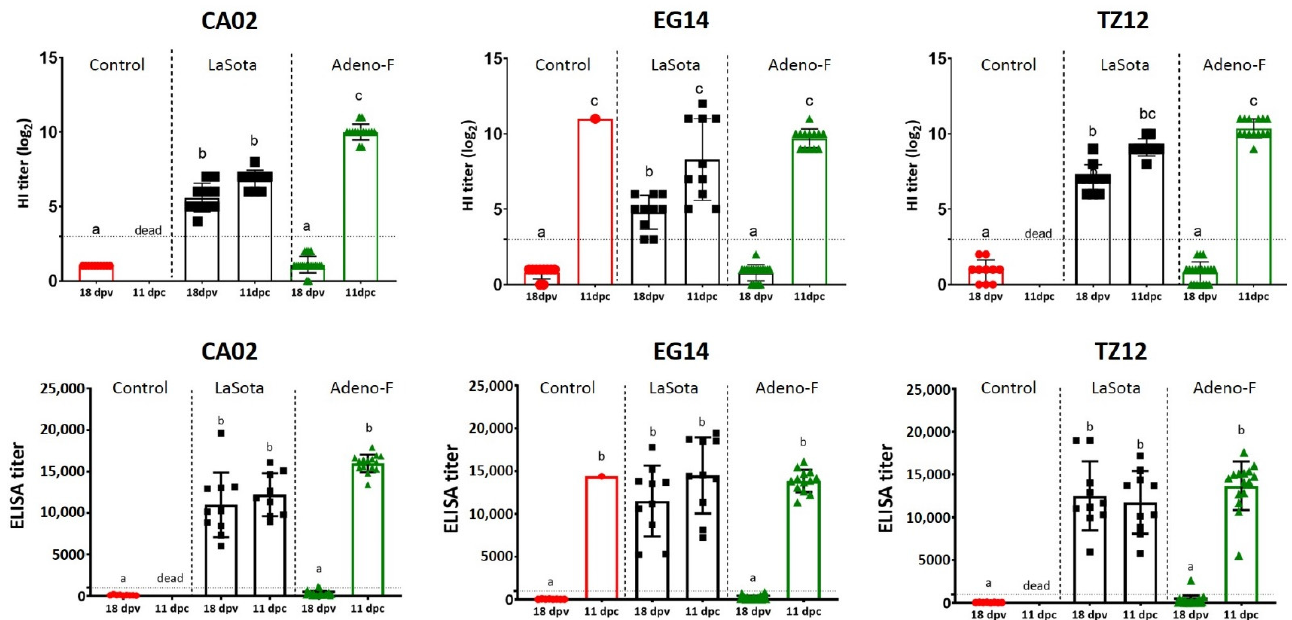
Figure 5. Antibody titers before and after challenge with NDV challenge strains. HI and ELISA tests were performed before and after the challenge using the homologous strains (CA02, EG14, and TZ12) in sera from control birds and birds vaccinated with LaSota or adeno-F vaccines. HI or ELISA antibody titers in sera samples from the different treatments (control, adeno-F, and LaSota) and NDV challenge strains were compared. Different letters (a, b or c) are statistically significant ( p < 0.05). dpv: days post-vaccination, dpc: days post-challenge.